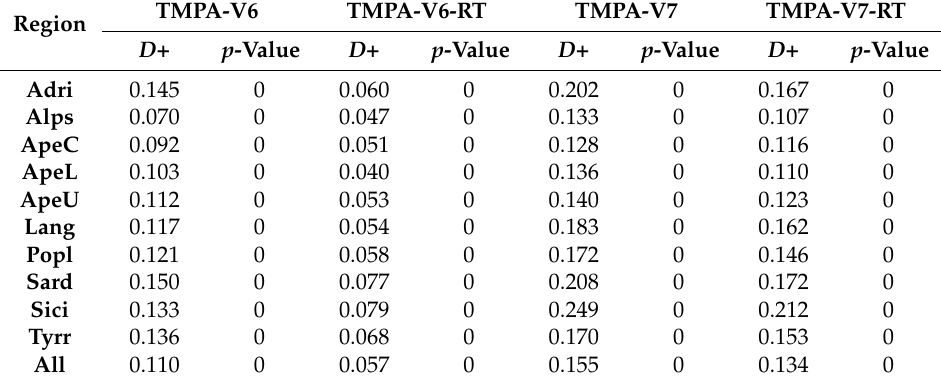
Table 5. Results of bootstrapped Kolmogorov-Smirnov test (hypothesis: greater) comparing the VRF data and the different satellite rainfall estimates (TMPA-V6, TMPA-V6-RT, TMPA-V7, TMPA-V7-RT) calculated in the entire Italian territory and in the different morphological subdivisions (see Table 2 and Figure 2). Given this comparison order and using the test greater hypothesis, p -values ∼ = 0 (for D + >> 0) indicate that the CDF of VRF data lies above (or to the left) of the CDF of the satellite estimates, and hence the satellite rainfall estimates distribution is statistically greater than that characterizing the VRF data (see Figure